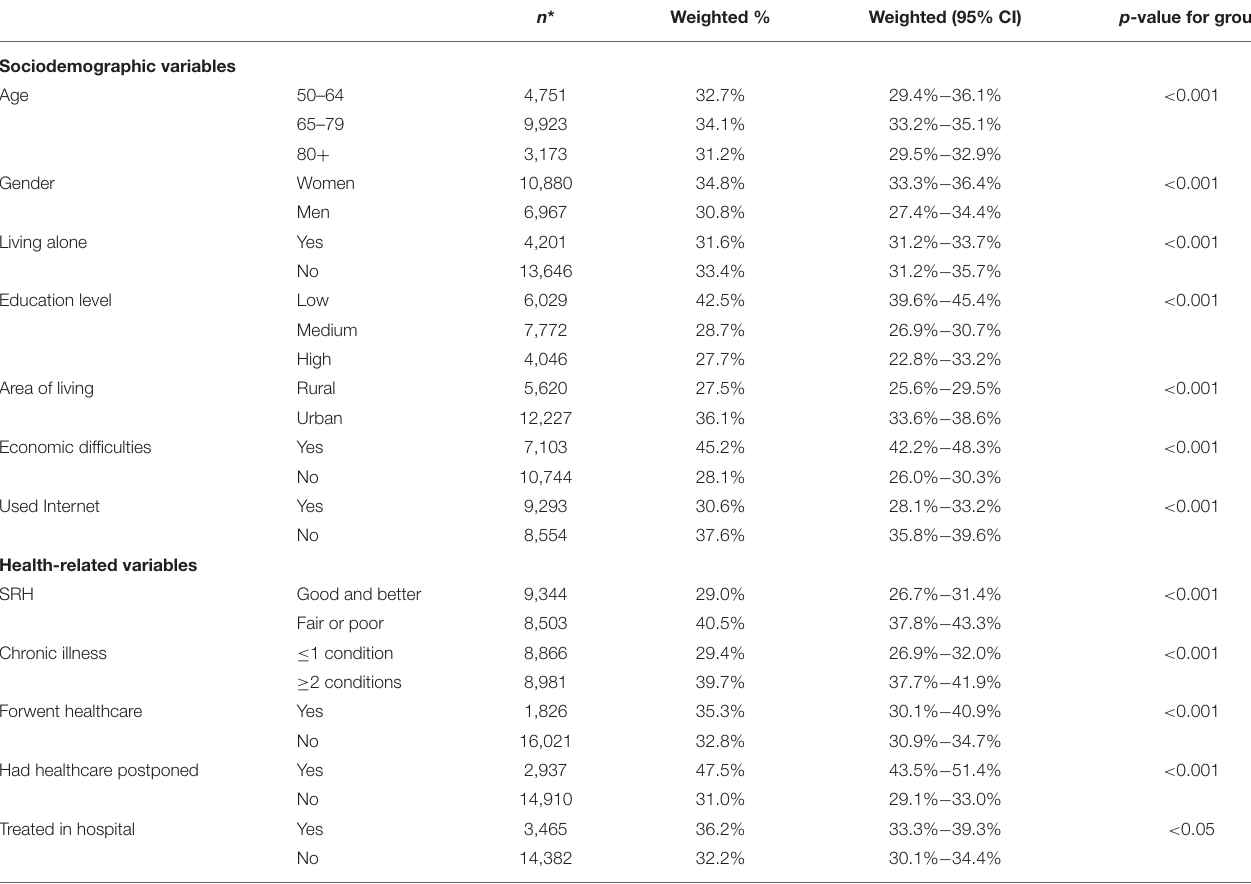
TABLE 2 | Use of remote medical consultations among people aged 50 and over in 27 European countries and Israel based on the second SCS June–August 2021. n